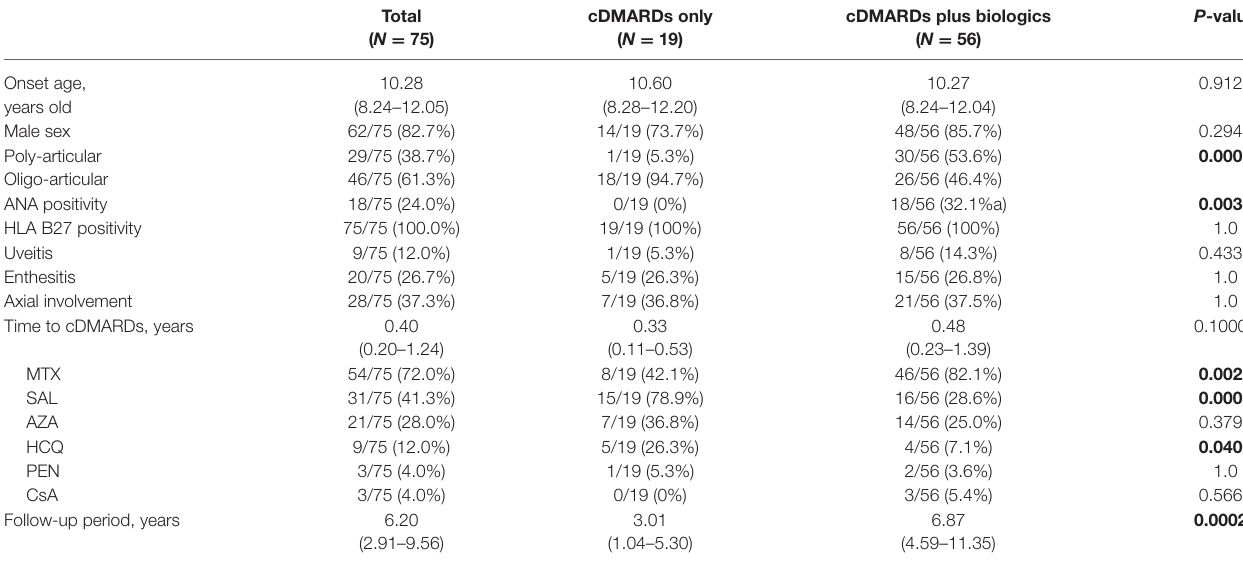
TABLE 1 | Characteristics of ERA patients with cDMARDs only and cDMARDs plus